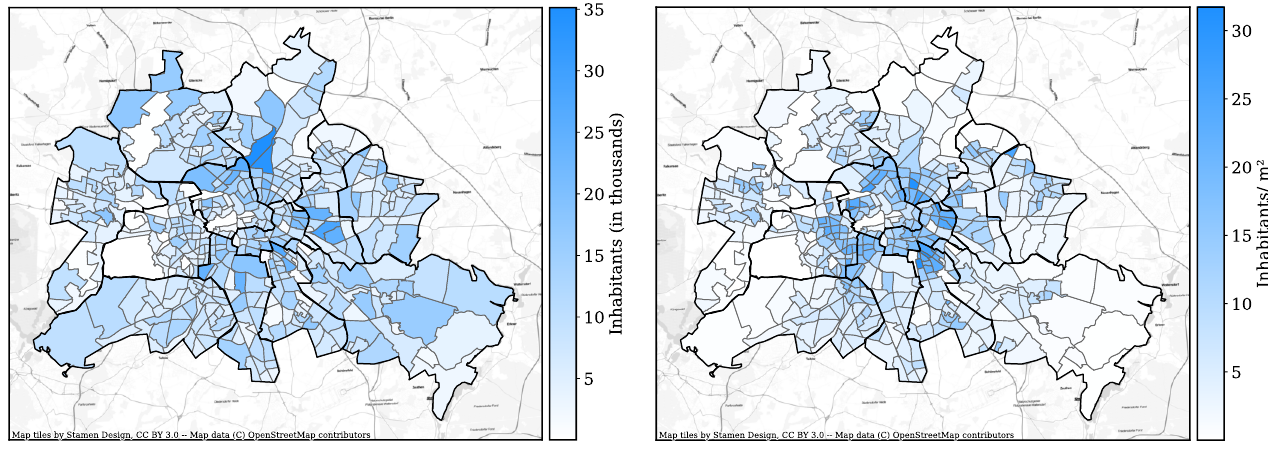
Figure 1. Distribution of the population in the Berlin subdistricts, “Lebensweltlich orientierte Räume”